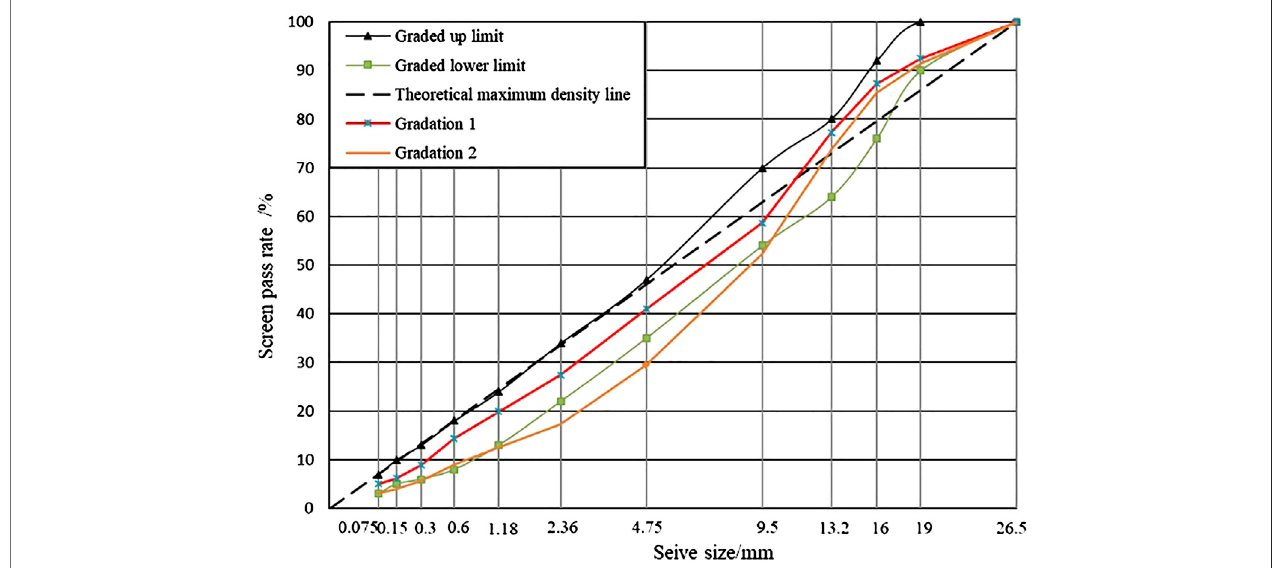
FIGURE 1 | Preliminary proposed gradation curve and theoretical dense skeleton gradation.